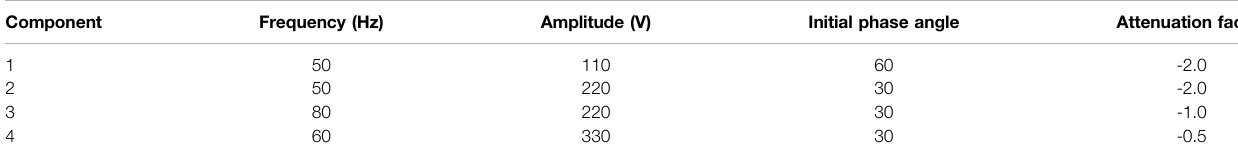
TABLE 1 | Speci fi c parameters of the smooth signal.